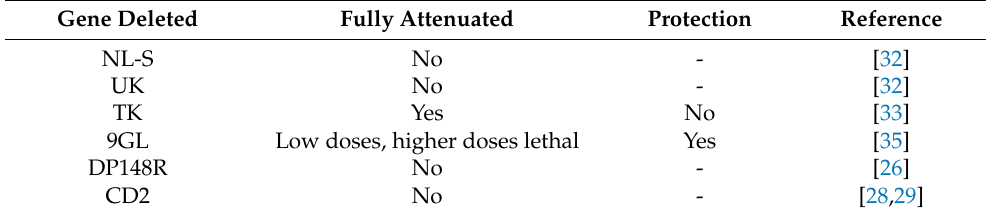
Table 2. Determinants of virulence that did not fully attenuate